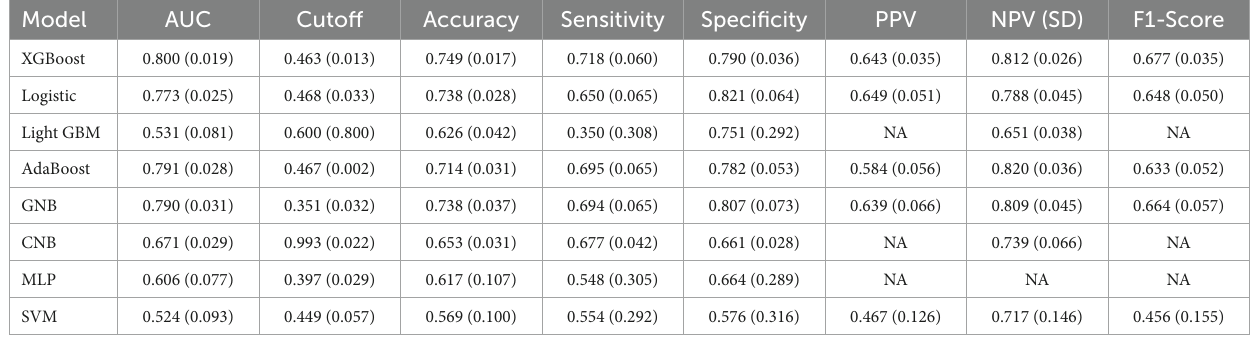
TABLE 3 Model parameters in validation set.